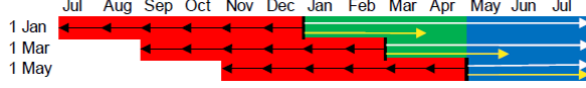
Figure 3. Temporal set-up of the experiments. Vertical black lines: forecast dates. Blue area: spring-flood period. Green area: lead time. Red area: full historical period used in the selection of analogue years (CP, TCI). Black arrows: time periods (1–6 months back in time) tested in the selection of analogue years (CP, TCI). Yellow ar- rows: time period (3 months ahead) used to calculate the predictors in the SD method. White arrows: forecasting periods in which the HBV model was run using full historical ensemble (CE), reduced analogue ensemble (CP, TCI) and ECMWF forecasts